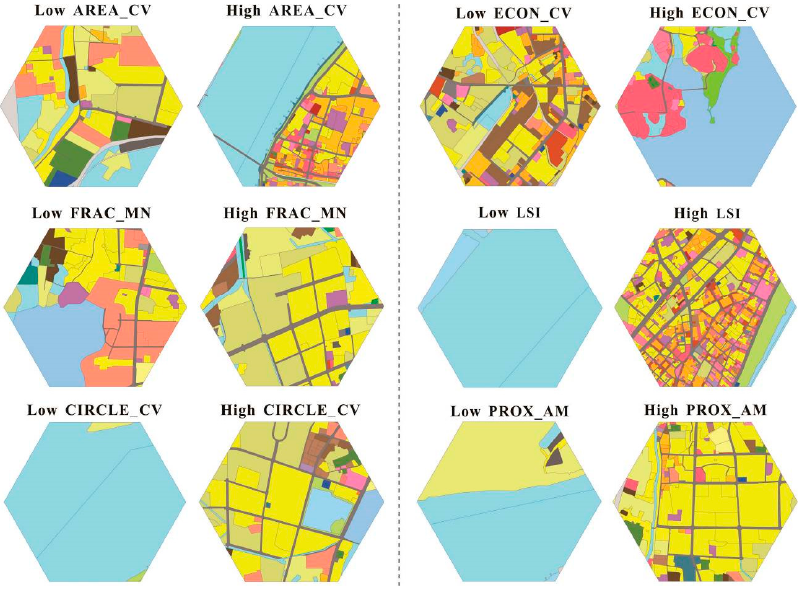
Figure 2. Resultant gradients of the landscape patterns illustrated with 500-ha hexagons. The highest LSI value was observed in a hexagon with a large number of high-density patches. The sample with the lowest LSI value contained only a small number of large-area water surface patches.